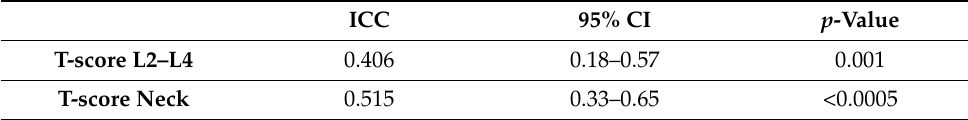
Table 5. Correlation between T-score and